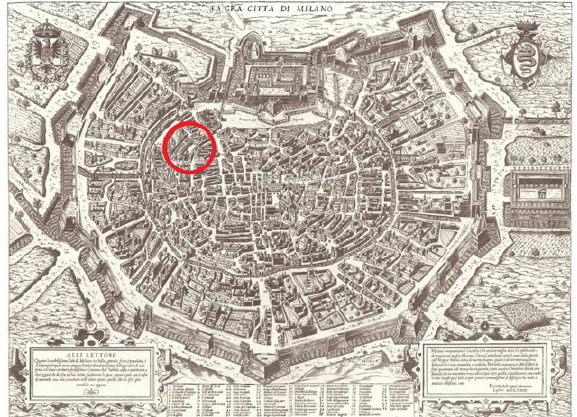
Figure 4. Milan perspective map - 1573 Antoine du Pérac Lafrery, preserved at the Civica Raccolta Stampe A. Bertarelli. Surrounded in red the study area